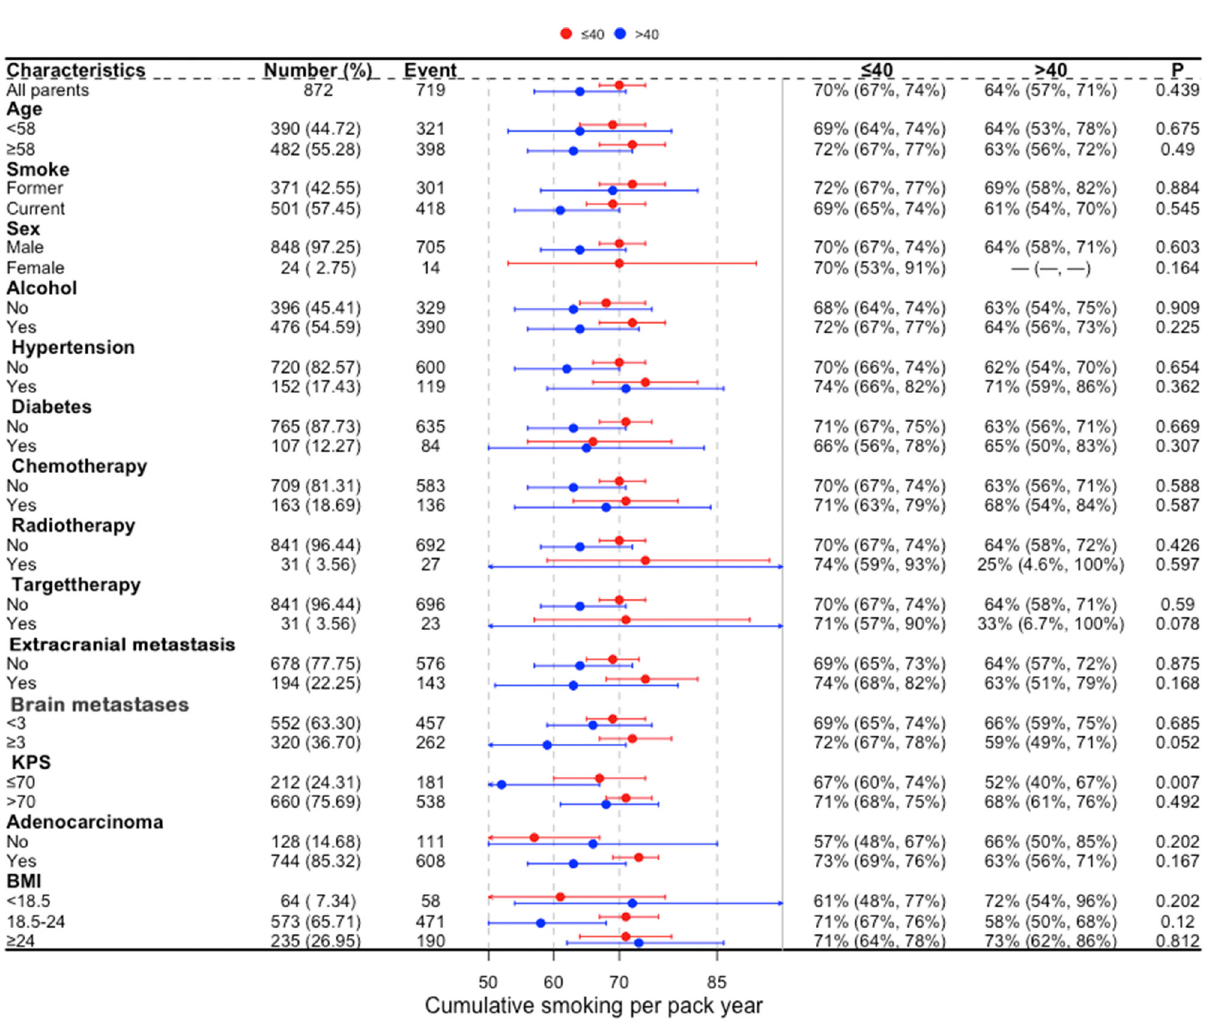
benefits of quitting smoking for the overall survival of patients [HR, 0.90 (CI, 0.77–1.04), p = 0.16] (Supplementary Figure 1). Figure